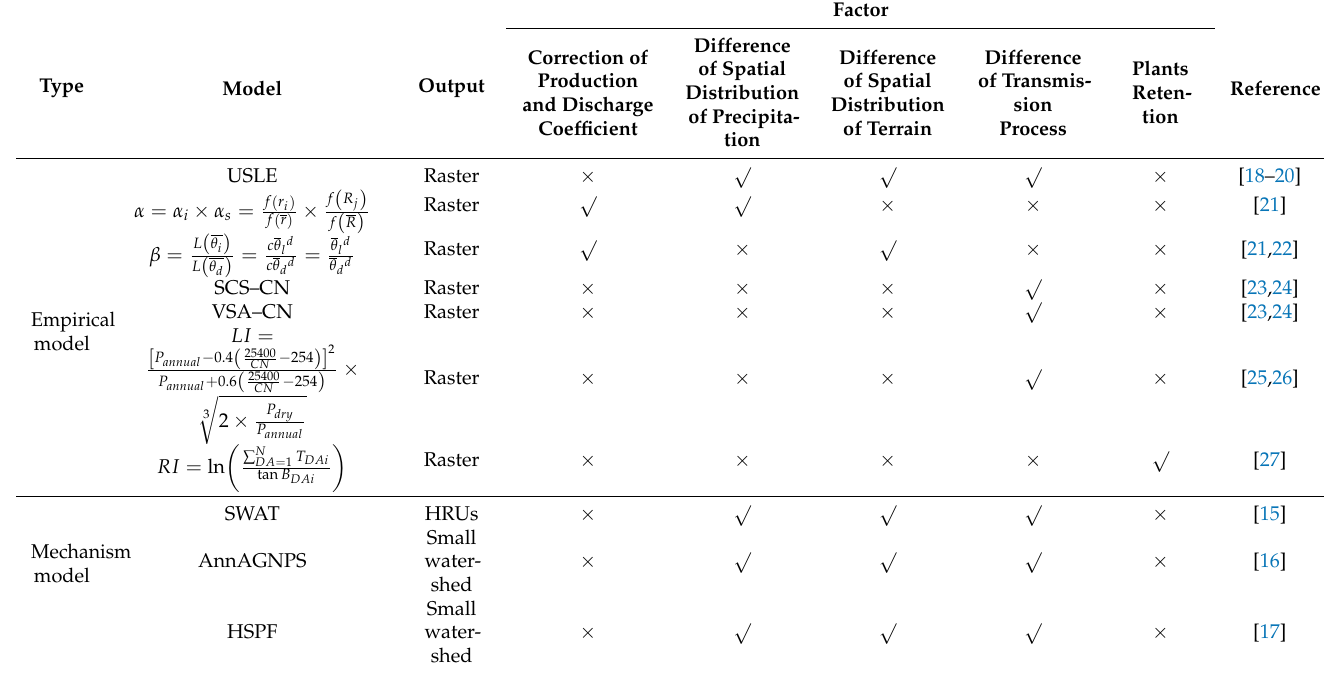
Table 1. Comparison of models for simulating agricultural nonpoint source